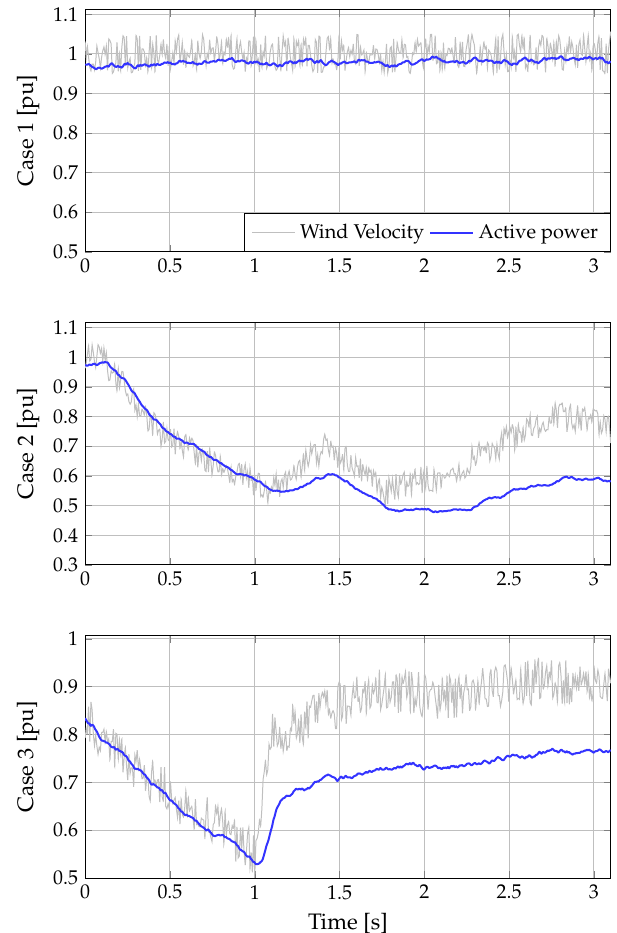
Figure 5. Wind velocity and active power delivered by WTGS for all